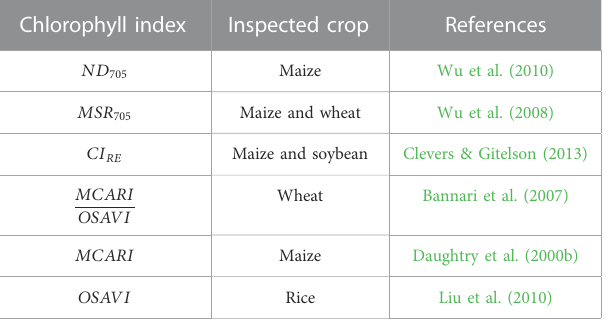
TABLE 5Calculated parameters k and b of linear models Chl = k × CI – b used to evaluate chlorophyll concentrations Chl from various CIs, and the corresponding values of the error functions ( R 2 and